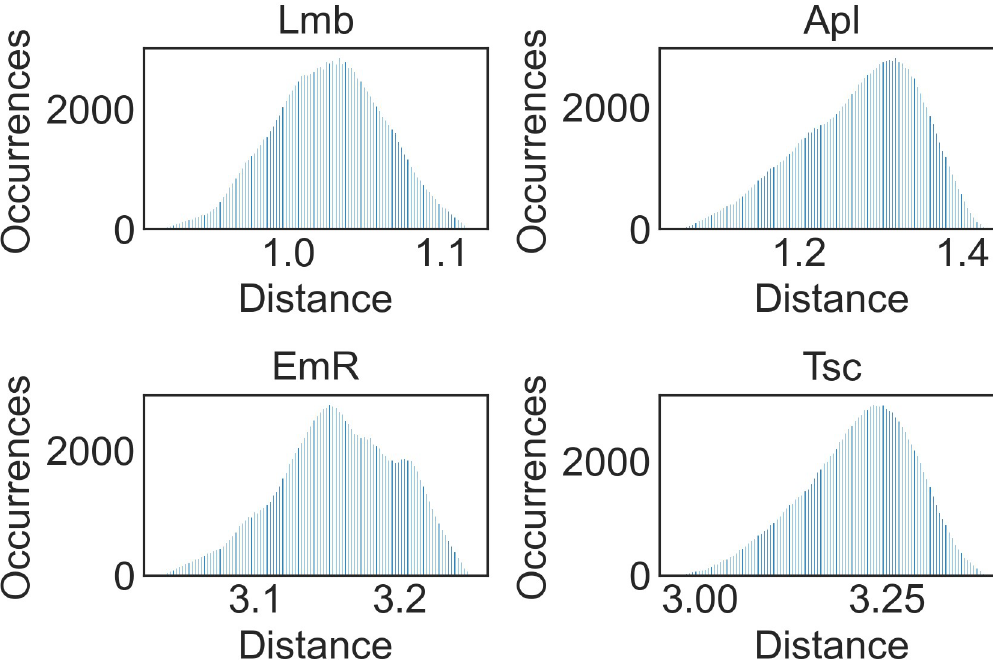
Fig 3. Moment-independent sensitivity measure δ for uncertain parameters in the pool of Italian regions and the average figure across regions.